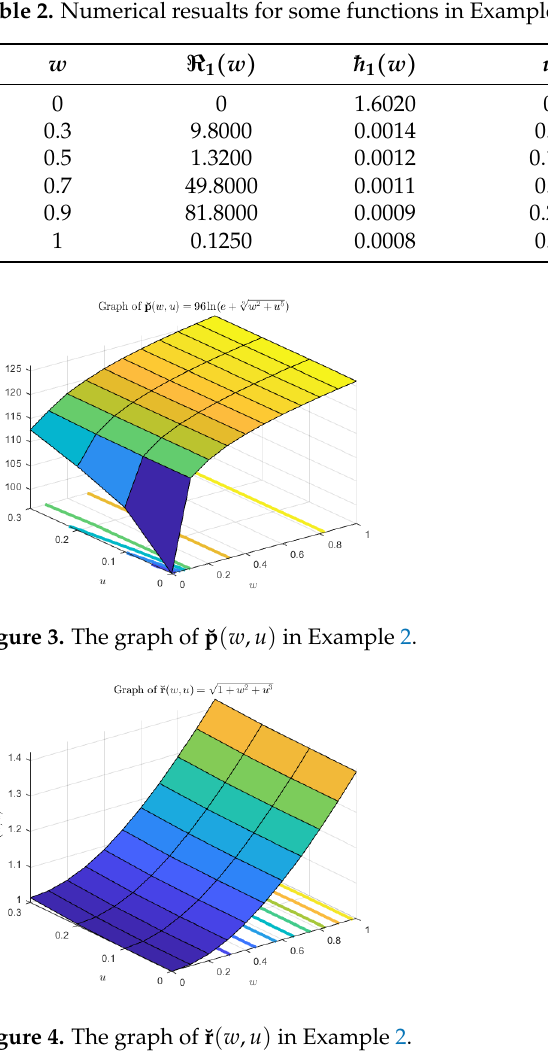
Figure 4. The graph of ˘r ( w , u ) in Example